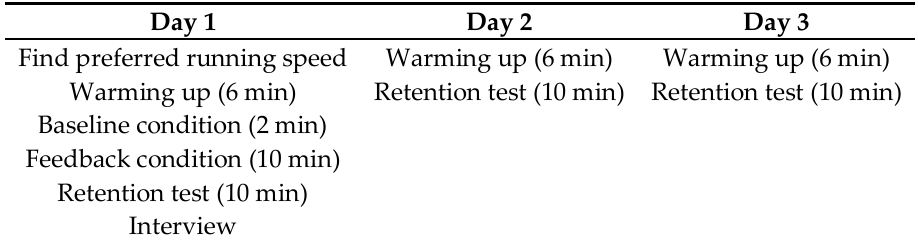
Table 1. Overview of testing. min =